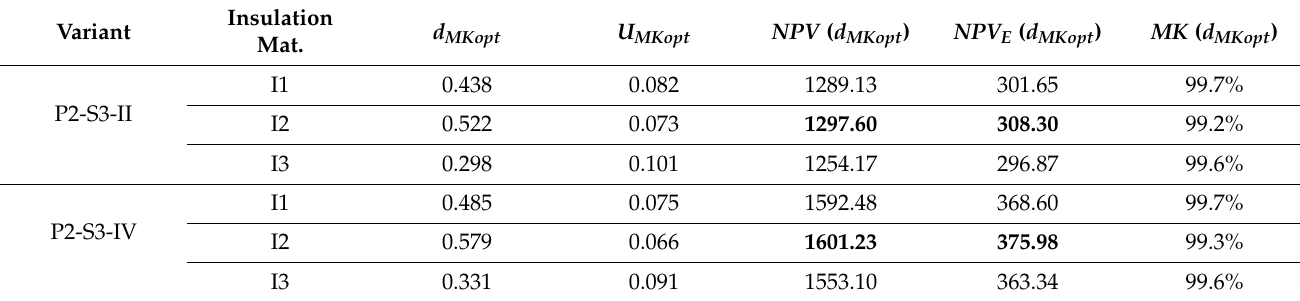
Table 14. Summary of results for Variant P2-S3-II I